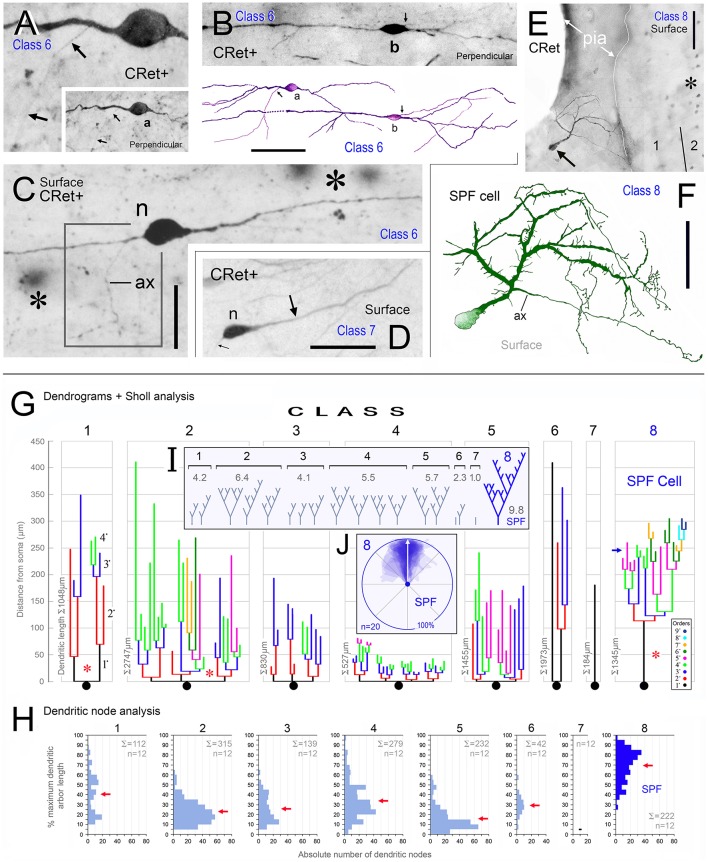
Calretinin immunopositive (CRet+) neurons in layer 1 of monkey PFC — Classes 6–8 (A–F). (A,B) Class 6. Perpendicular views of two deep horizontal bipolar CRet+ neurons (a, area 25; b, area 9) in lower layer 1. Fine axonal processes are indicated (arrows). Composite drawing of cells a and b. Scale bar: 100 μm. (C) Class 6. Area 24c. Surface view showing a deep horizontal bipolar CRet+ neuron in lower layer 1. Profiles of CRet+ neurons in upper layer 2 (lying deeper in the section) are seen (asterisks). (Axon, ax). Scale bar: 50 μm. (D) Class 7. Area 24c. Simple unipolar CRet+ neuron (n). (Dendrite arrowed). Scale bar: 50 μm. (E) Class 8. Area 46d. CRet+ SPF cell (arrow). CRet+ neurons in layer 2 (asterisk). Pial surface is indicated (oblique view). Scale bar: 50 μm. (F) Reconstruction of the cell in (D). Note unipolar soma and elaborate fan-like arrangement of higher order dendrites which give rise to numerous thorns. An axon arises proximally along the primary dendrite. Scale bar: 50 μm. Morphometric analysis of dendritic arbors (G–J). (G) Dendrograms for the eight classes of CRet+ neurons in layer 1 of adult monkey showing the lengths, nodal points. and main dendritic segments (filamentous and thorn processes are not indicated, asterisks). A single representative cell in each class is shown. (H) Bar charts of the distribution (absolute number) of dendritic node locations as a function of maximum dendritic arbor length (100%). [Data from 12 cells in each class are presented. Total absolute numbers of nodes (Σ) are given]. Note the highly characteristic distribution of nodes for class 8 SPF cells. (Means of distributions, red arrows). (I) Dendritic tree topologies of the 8 CRet+ cell classes presented in H together with the corresponding WeST values (1.0–9.8). (J) Outlines of 20 SPF cell dendritic boundaries superimposed over their major caliper axes. Somata centroids act as root points.